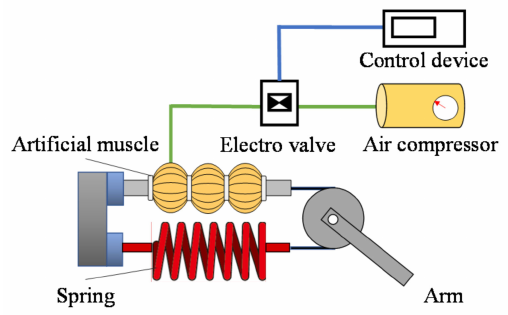
Figure 1. Schematic of one side spring antagonized joint [18–20].